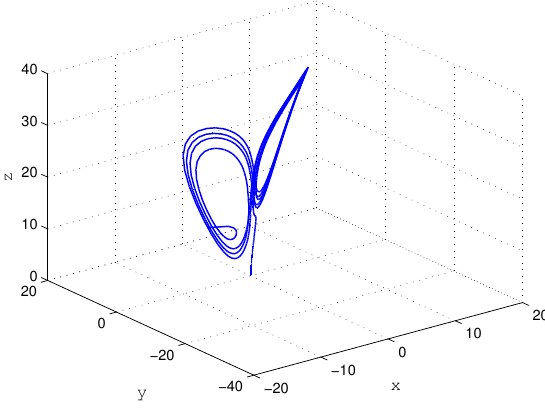
Figure 3. Phase portrait of the controlled